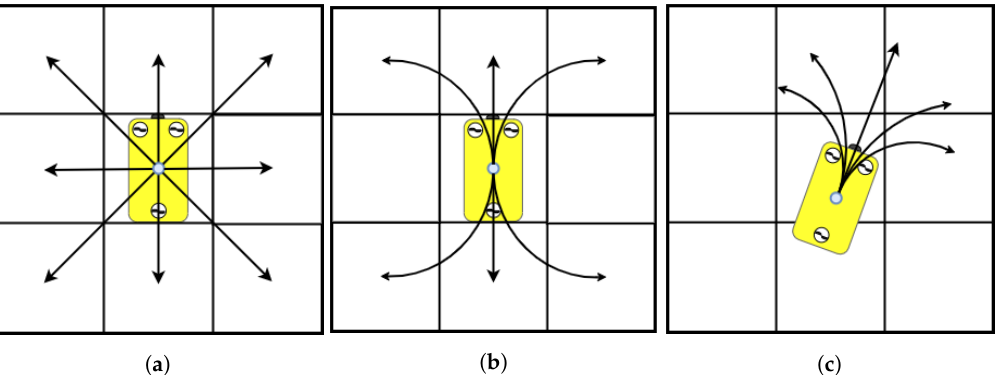
Figure 1. ( a ) A* and Dijkstra’s algorithm use discrete states in the centre of a cell. ( b ) State-lattice A* can connect the centre of cells using curvatures and straight lines [12]. ( c ) Hybrid A* (HA*) uses continuous values for states within cells instead of discrete location of states. This allows for smooth paths which can utilise a larger configuration space (C-Space) than ( a , b